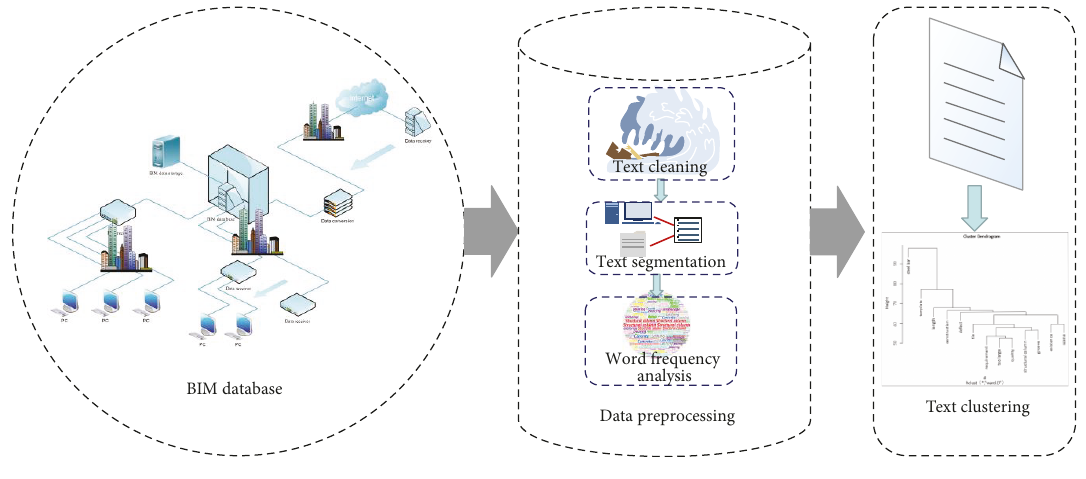
Figure 3: The process of text